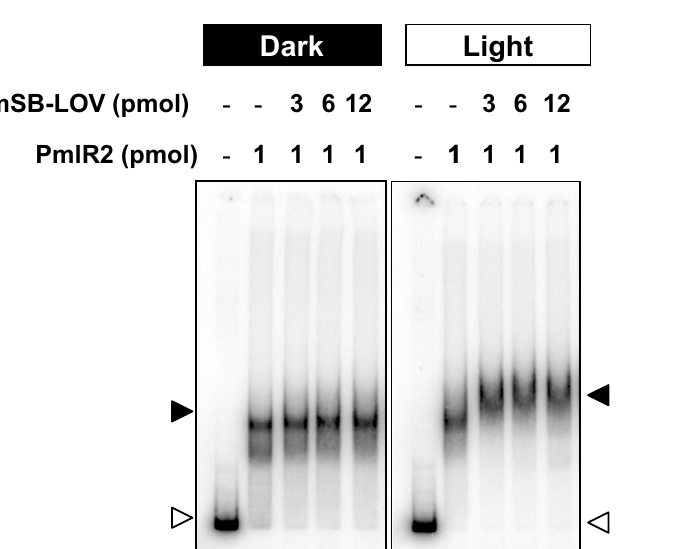
Figure 4. Two-hybrid system analysis of PmlR2 and PmSB-LOV in E. coli . The E. coli BTH101 transformants carrying pUT18C- pmSB-LOV /pKT25- pmlR2 and pUT18C- pmlR2 /pKT25- pmSB-LOV were cultured under dark (solid line) and light (dashed line) conditions. In each vector, PmlR2 and PmSB-LOV were fused at the C-terminus of the split adenylate cyclase domain. β-galactosidase activity indicating protein–protein interaction was measured at 8 and 12 h. The BTH101 cells carrying pUT18C/pKT25 and pUT18zip/pKT25zip were used as negative and positive controls, respectively. Two independent experiments in biological replicates were performed, and representative data were shown.